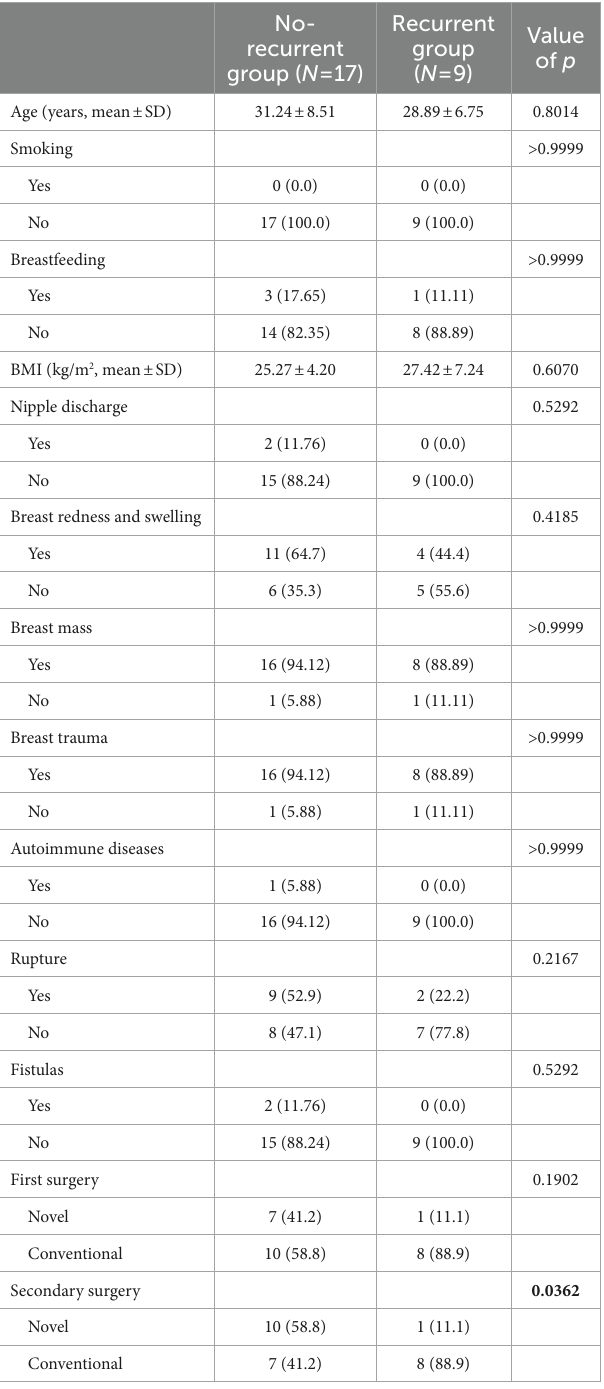
TABLE 6 Logistic regression for the predictors of recurrence in PCM patients after receiving secondary surgical